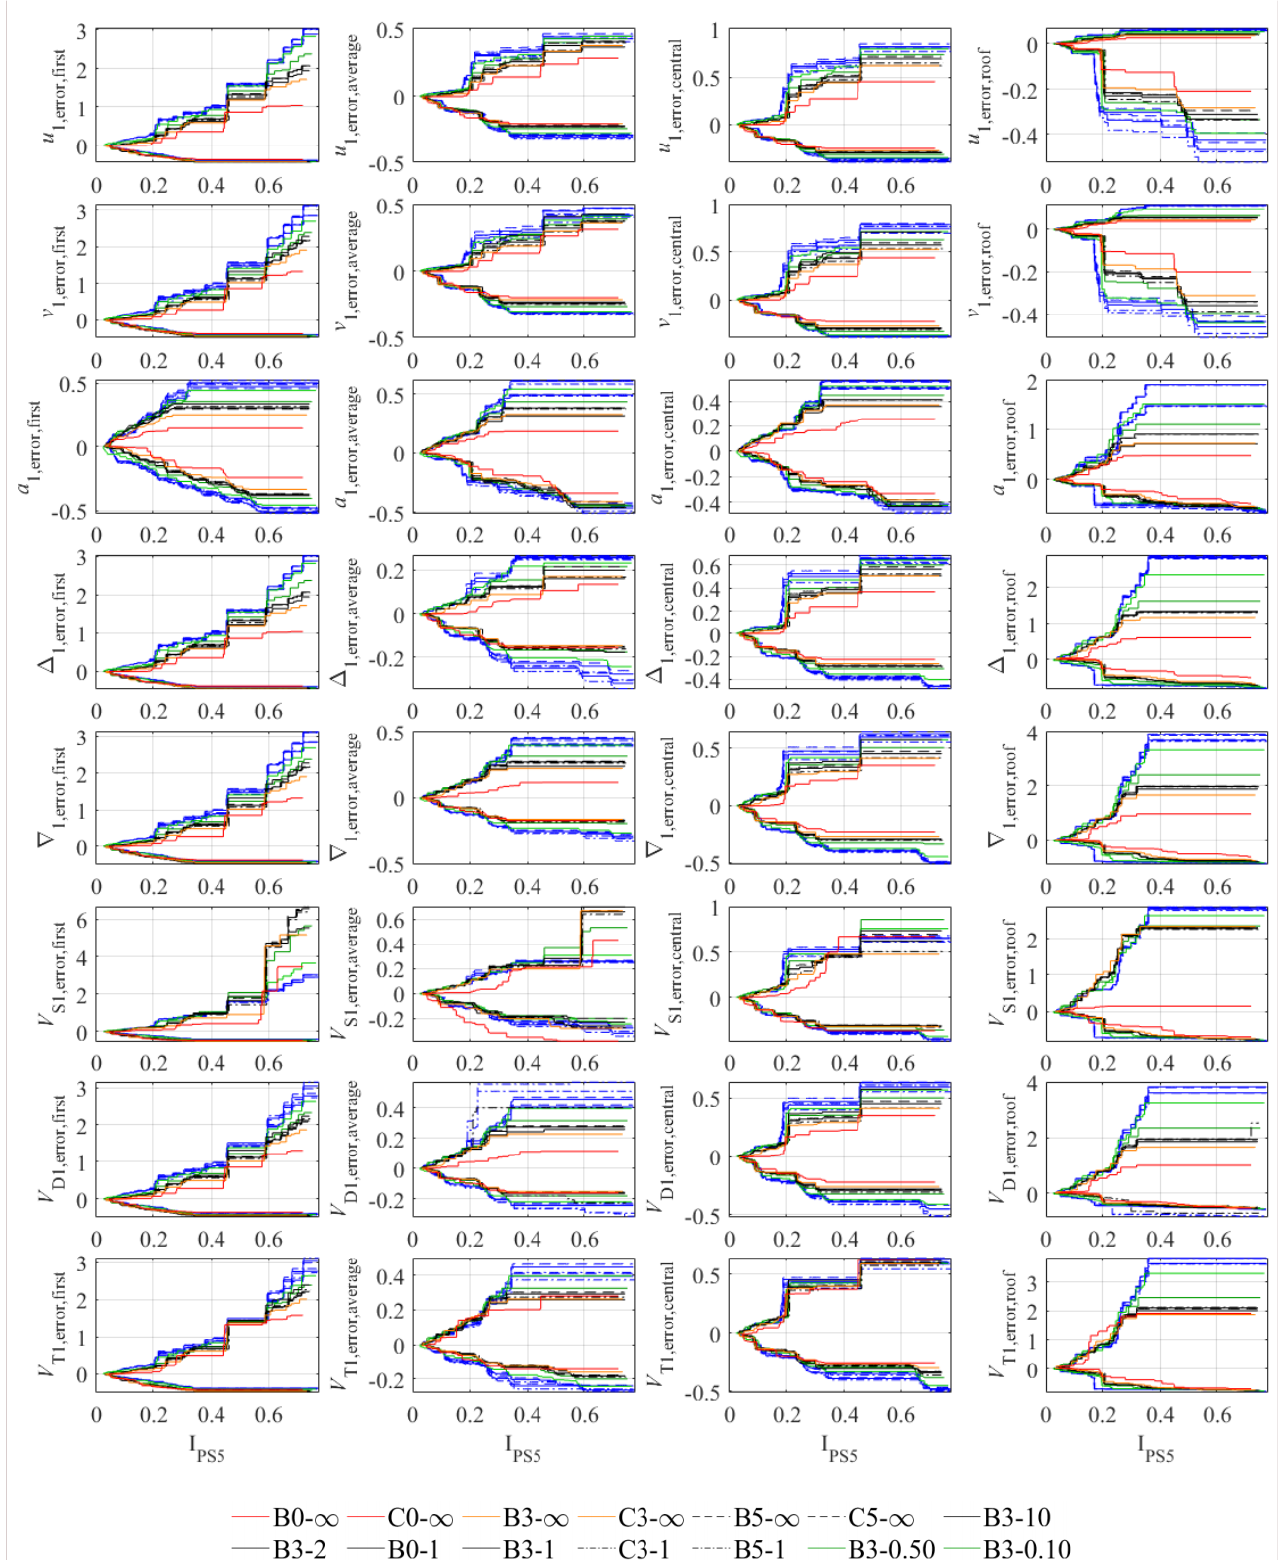
Figure 8. THMA error (type 1) max and min envelope for all cases versus index I PS 5